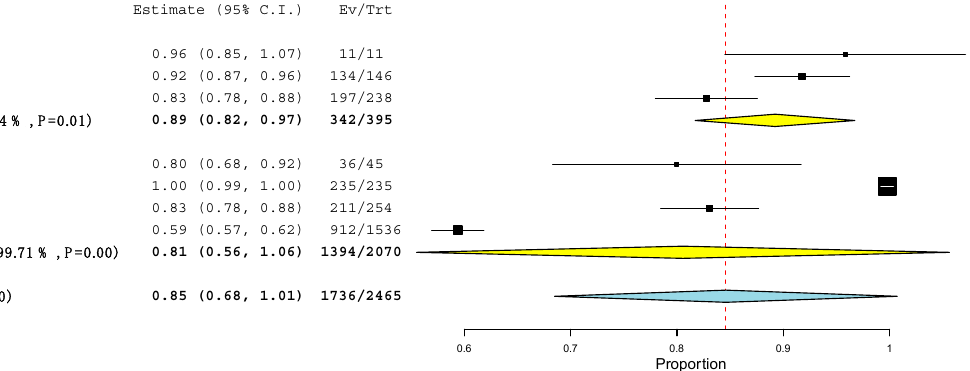
Figure 5. Sensitivity of 18 F-FES PET/CT at the level of the lesions across studies. 4. Discussion In this systematic review and meta-analysis, we aimed to clarify the diagnostic role of 18 F-FES PET/CT in BC patients compared to 18 F-FDG PET/CT. In fact, 18 F-FES PET/CT has gained significant attraction as a non-invasive means to predict the effectiveness of hormone blockade. However, its potential in the mere diagnostic evaluation is still debated [1,8,21]. In this study, we gathered all the available evidence of its sensitivity in ER+ BC patients when compared with the more commonly used 18 F-FDG PET/CT. Our qualitative and quantitative assessment in this particular BC subpopulation showed that there are no significant differences in terms of sensitivity between the two PET tracers at the PBA. Indeed, both molecular imaging modalities proved able to detect patients affected by ER+ BC with similarly high sensitivity. The lack of significant difference between these two modalities can, however, be explained by the selection of patients included in the analysis. These patients were evaluated at the time of first staging for an already known primary tumour or who underwent PET at the time of relapse to evaluate the extension or the ER expression of the metastatic disease. This population is indeed characterized by a very high prevalence of a true positive BC lesion; the probability